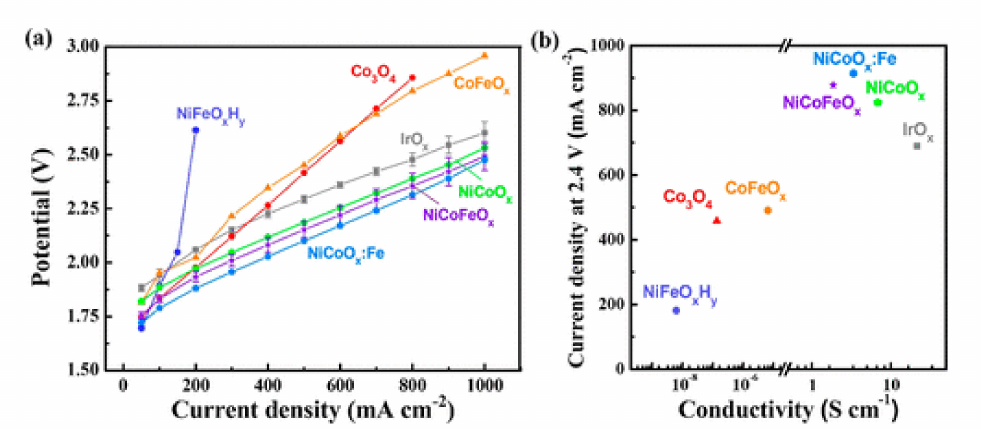
Figure 4. ( a ) Initial polarization curves of AEM water electrolyzers with several OER catalysts. ( b ) Current density in the electrolyzer at fixed applied voltage (2.4 V) correlated with the correspond- ing catalyst electrical conductivity. Reprinted with permission from [41]. Copyright 2019 American Chemical